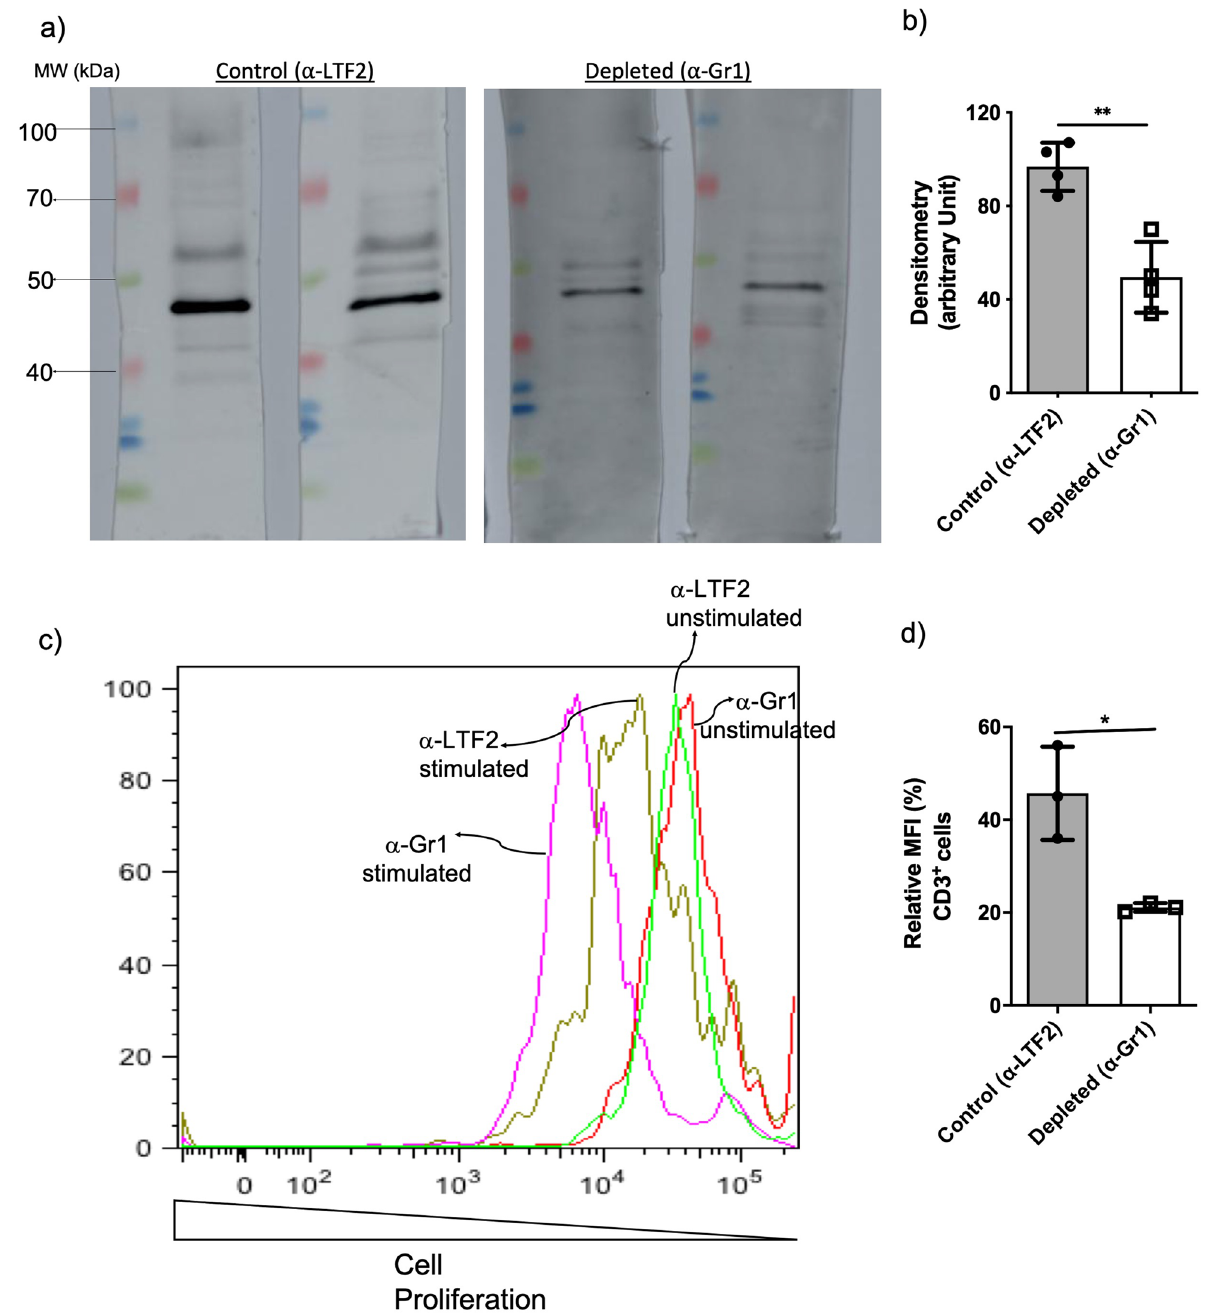
Figure 5. B and T-cells immune response after 14 days of infection with F. pedrosoi : B-cell response was analyzed by specific-antibody production against F. pedrosoi antigens by Western blot ( a ). The F. pedrosoi specific antibody production by isotype control and neutropenic animals was assessed by Western blot using the serum from previously infected animals against purified proteins of F. pedrosoi . Briefly, F. pedrosoi antigens were separated by SDS-PAGE electrophoresis and then transferred to the nitrocellulose membrane. Then, the membranes were cropped, and each membrane strip—containing the ladder and the F. pedrosoi purified proteins—were incubated with the sera of one animal—previously infected with F. pedrosoi (isotype control or neutrophil-depleted animal). All the membranes were developed simultaneously, therefore, with the same exposure time. Densitometry of Western blot bands confirmed the lower production of F. pedrosoi specific- antibodies in neutropenic animals ( b ). T-cells harvested from the spleen of neutropenic animals showed a higher capacity of in vitro proliferation ( c , d ). Data are expressed as the mean ± SD of three to four mice per group. The results are one representative of two independent